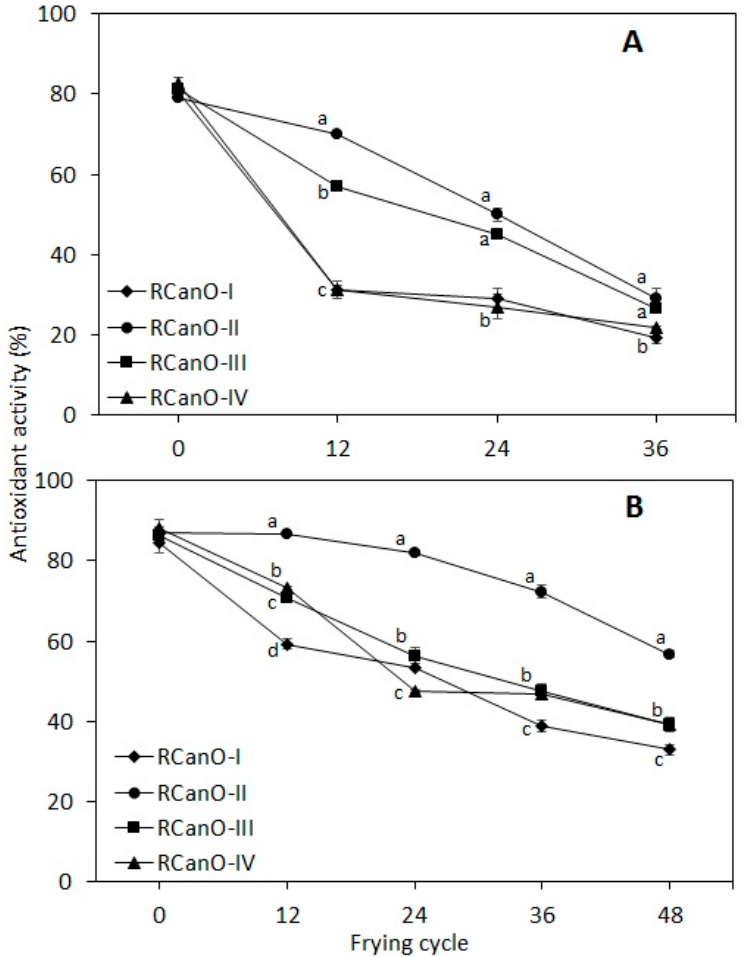
Figure 7. Antioxidant activity of canola oils during 36 and 48 frying cycles: ( A ) 2016/2017 ( n = 36) and ( B ) 2017/2018 ( n = 48) production seasons. Different letters show means that are statistically significant from each other ( p < 0.05).